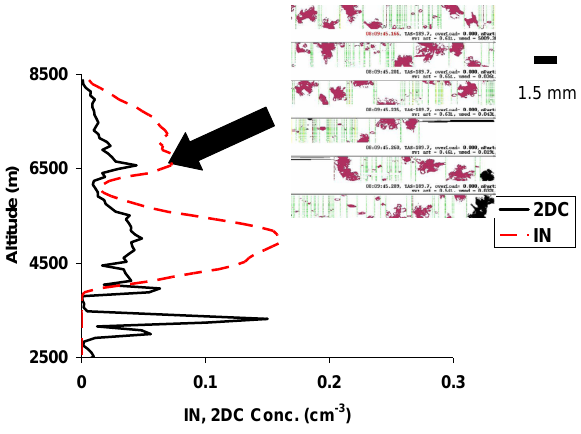
Fig. 7. Vertical profile of IN and 2DC concentrations in the warm sector cloud just above the front with the CFDC sampling from the CVI inlet. The location of the profile is in the lower left hand dark track in Fig. 1. The freezing level was at 4.2km altitude. The CFDC was operated at a temperature between − 30 and − 33 ◦ C. 2DC ice particle images from the 2DC taken at 6.5km altitude are also shown.